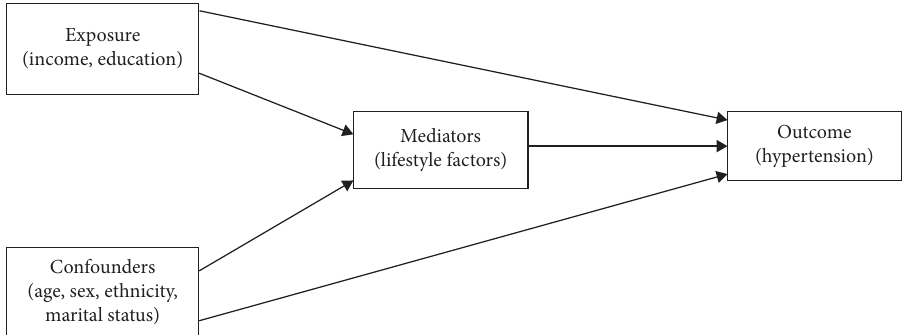
Figure 1: Hypothesized causal diagram. Exposure has a direct and indirect effect on the outcome, indirect via the mediators (tobacco use and alcohol intake, physical activity, BMI, and fruits and vegetables servings). Age, sex, ethnicity, and marital status are used as